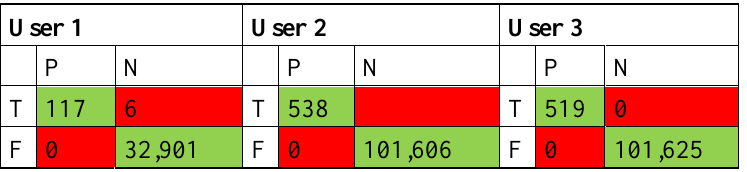
Table 2. Confusion matrix for the R wave I.